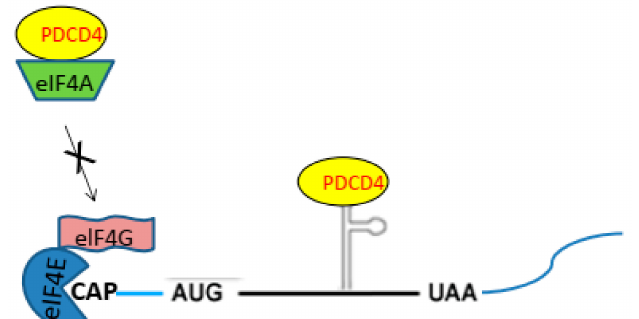
Figure 3. Controls of translation by PDCD4. PDCD4 binds to eIF4A and inhibits its helicase activity suppressing the protein synthesis. Also, PDCD4 binds to the special secondary structure of mRNA and inhibits the protein